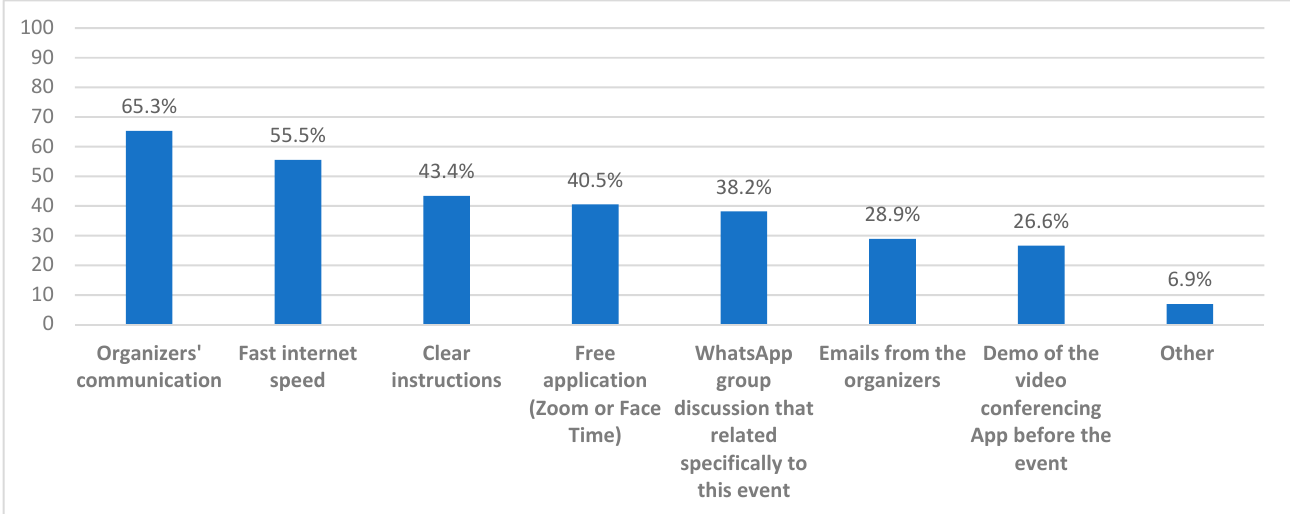
Figure 8. The faculty members’ perceived factors that enhanced the medical residents’ E-interviews experience.